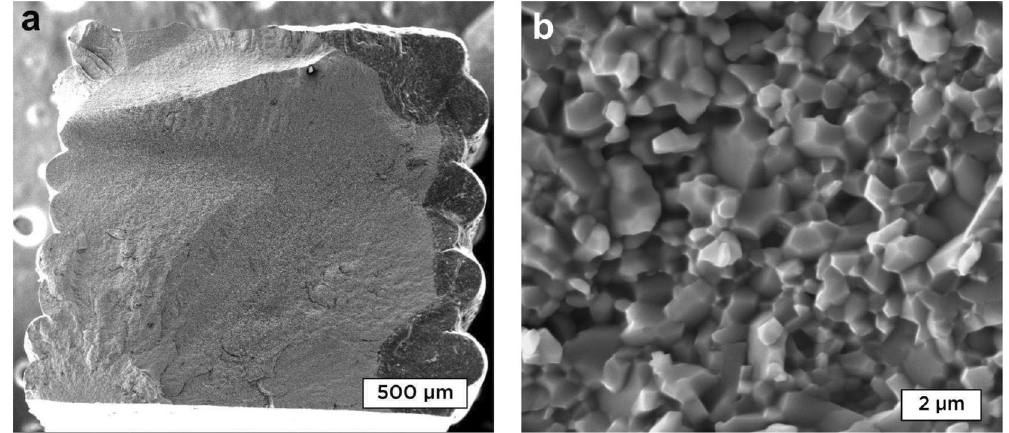
Figure 10. ( a ) SEM image at x120 of fracture surface from Al 2 O 3 bar obtained by sintering boehmite printed with DIW. Fracture resulted from Three-point bending test. Stacked lines are not discernible in the center of the sample, but clearly visible on the samples surface. ( b ) SEM image at x10000 of the same fracture surface. The object is dense with a fine grained microstructure, suitable for high strength mechanical